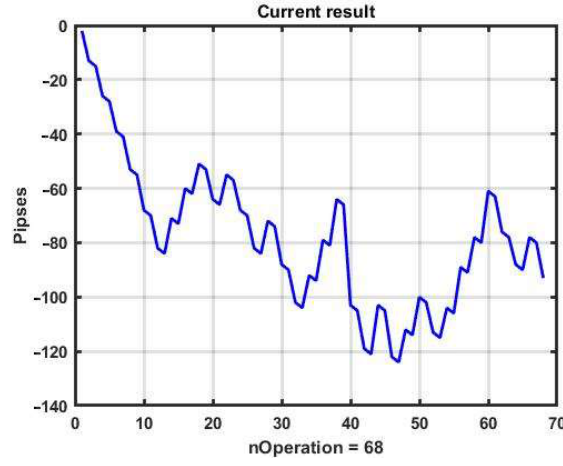
Figure 2. Performance in the case of using CSF.